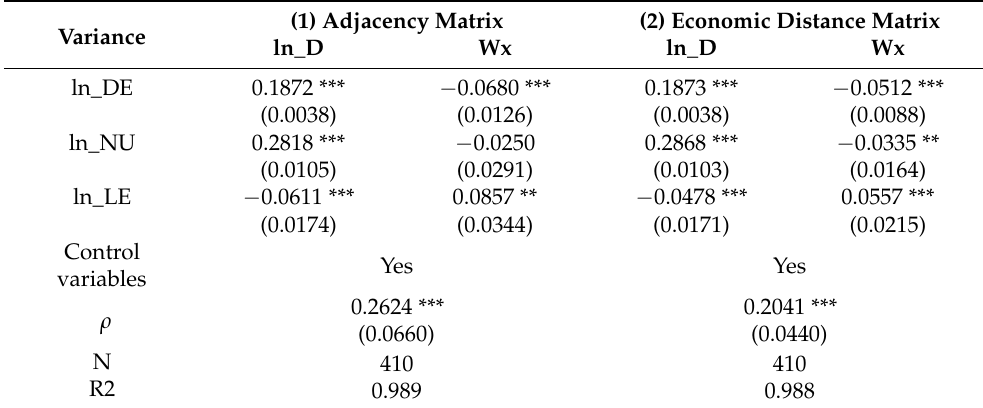
Table 8. Estimation results of the spatial Durbin model.